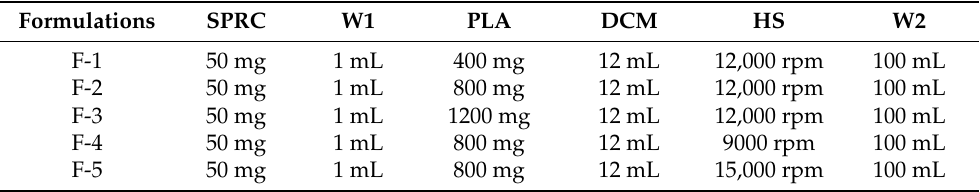
The formulations of different SPRC-loaded poly (lactic acid) (PLA) microspheres